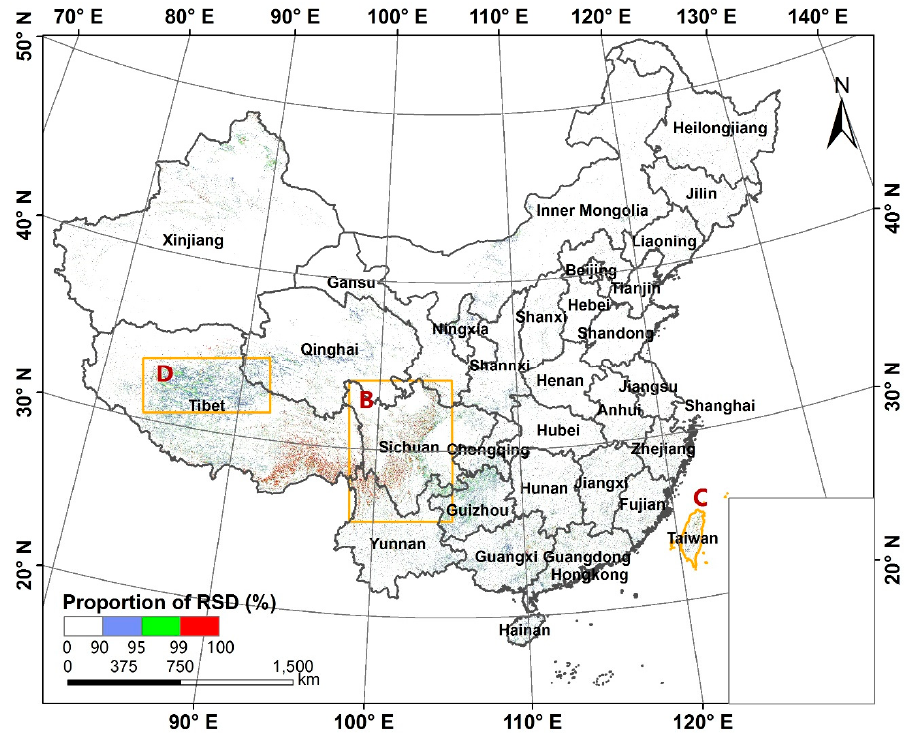
Figure 16. Percentile distribution of relative standard deviation of four LAI climatologies over China. Blue represents 90% percentile level, green represents 95% percentile level, and red represents 99% percentile level. Table 8. Pixel proportion of different biome types at three relative standard deviation percentile levels.